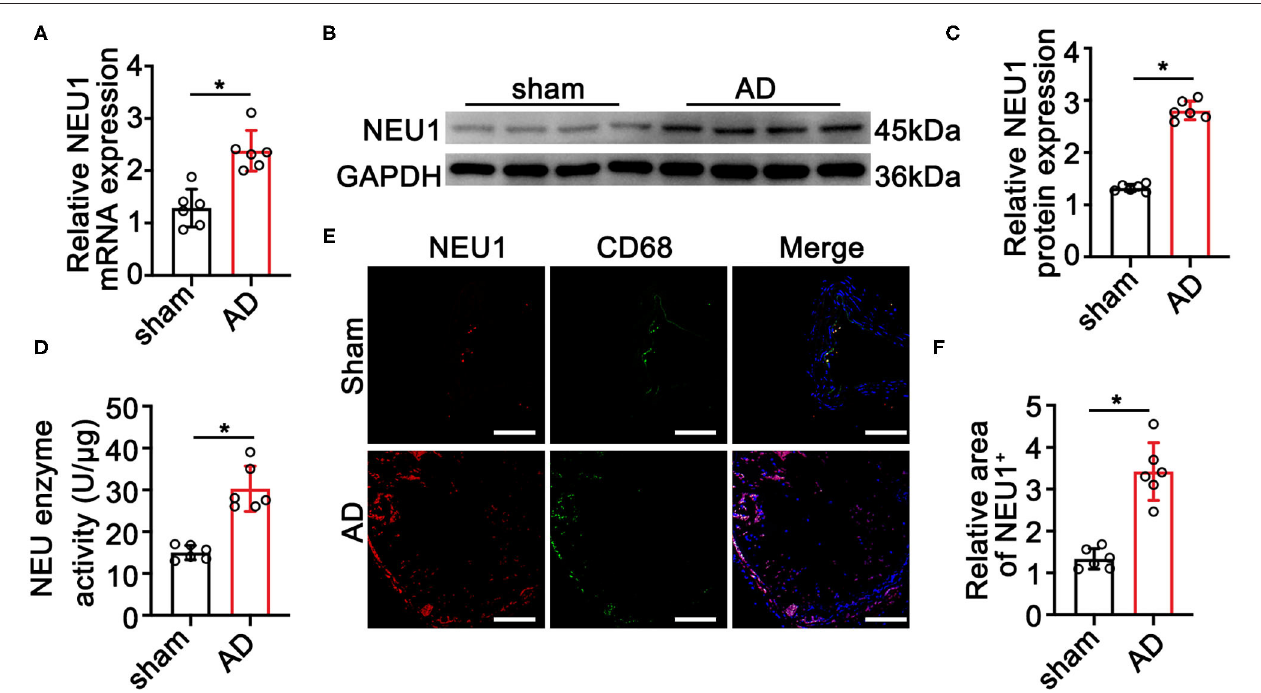
FIGURE 1 | Neuraminidase 1 (NEU1) expression increases in aortic dissecting (AD) tissues. (A) Quantitative results of NEU1 mRNA level in aortas of mice subjected to BAPN induction for 4 weeks ( n = 6 mice per group). (B,C) Representative western blots and quantitative results of NEU1 level in aortas of mice subjected to BAPN induction for 4 weeks ( n = 6 mice per group). (D) The neuraminidase enzyme activity of AD in mice by ELISA ( n = 6 aortas per group). (E,F) Immunofluorescence staining with anti-NEU1 (red) and anti-CD68 (green) antibody in slices from the indicated mice aortas ( n = 6 mice aortas per group; scale bar: 50 µ m). Data are presented as mean ± SEM. (A,C,D,F) unpaired two-tailed t -test. BAPN, β -aminopropionitrile monofumarate; NEU1, neuraminidase 1. * p <